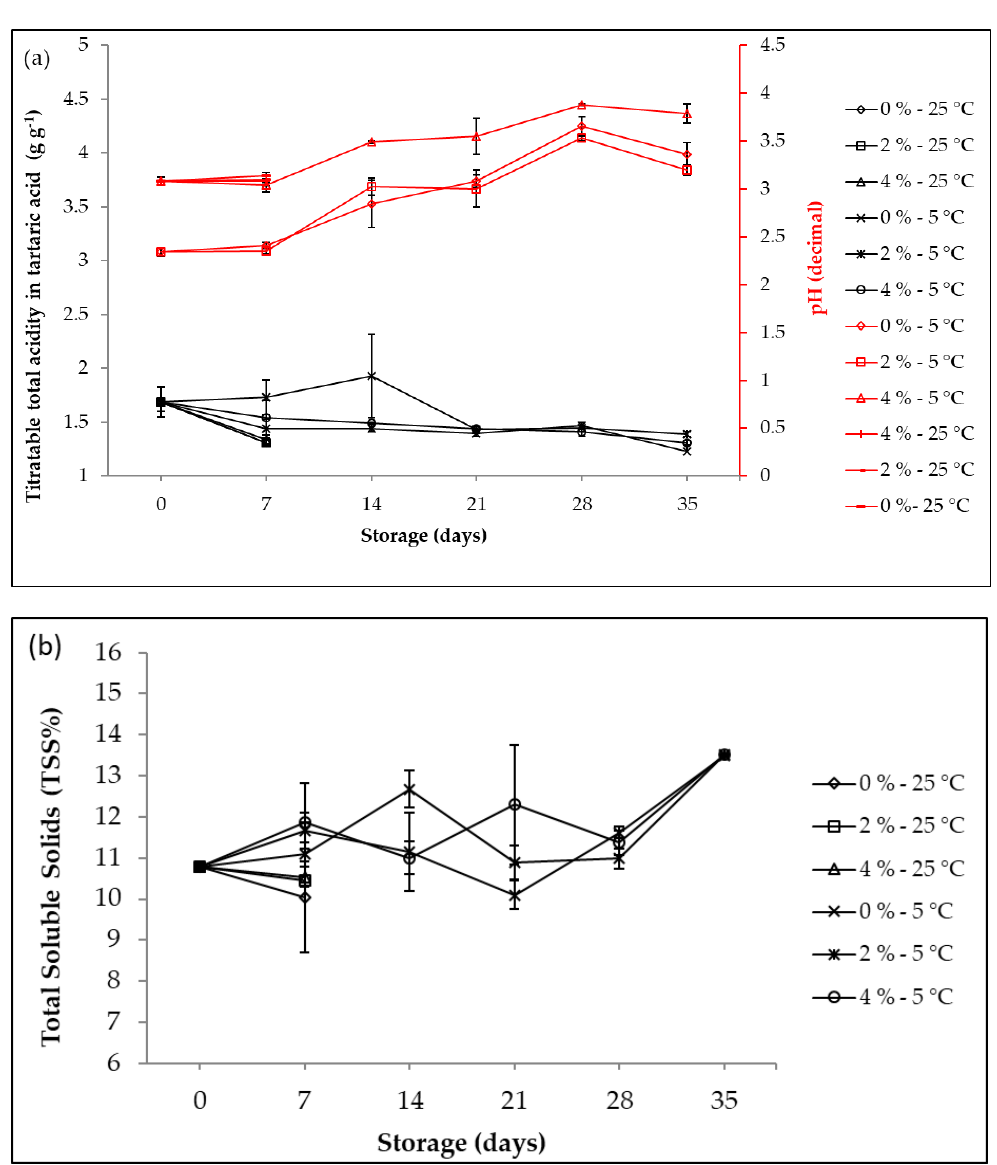
Figure 4. Titratable total acidity in tartaric acid (g g −1 ) and pH (decimal) ( a ) and total soluble solids (TSS%) ( b ) of plums with different concentrations of edible coating stored for up to 7 days at 25 °C and 35 days at 5 °C. Table 4. Anthocyanins content (mg g −1 of fresh pulp) of plums with different edible coating concentrations, stored for up to 7 days at 25 °C and 35 days at 5 °C. Storage (Days) Treatments